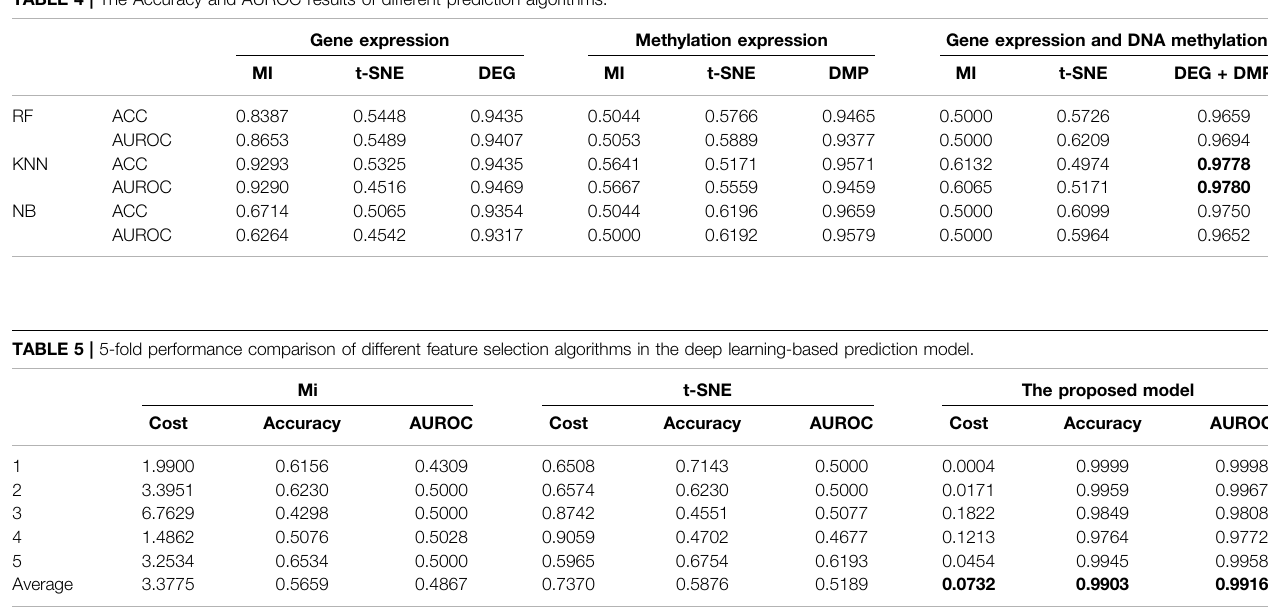
TABLE 4 | The Accuracy and AUROC results of different prediction algorithms.